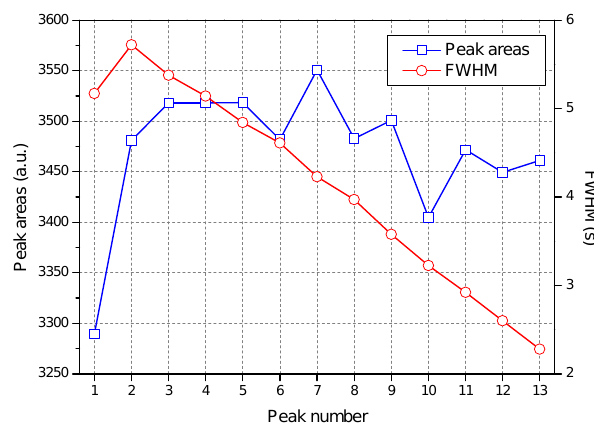
Fig. 9. The integrated peak areas of the propene peaks as shown in Fig. 8. Also shown is the FWHM of all the corresponding peaks.